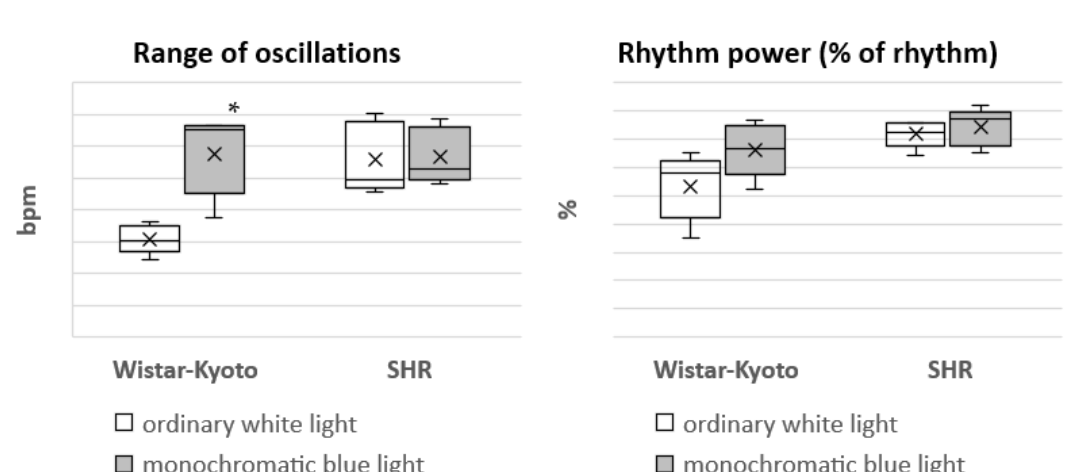
Figure 8. Indicators of 24 h HR profiles obtained on the basis of nonlinear analysis in Wistar–Kyoto and SHR rats under the standard light pattern (12 h:12 h) with ordinary white light and monochromatic blue light. *— p ≤ 0.05.